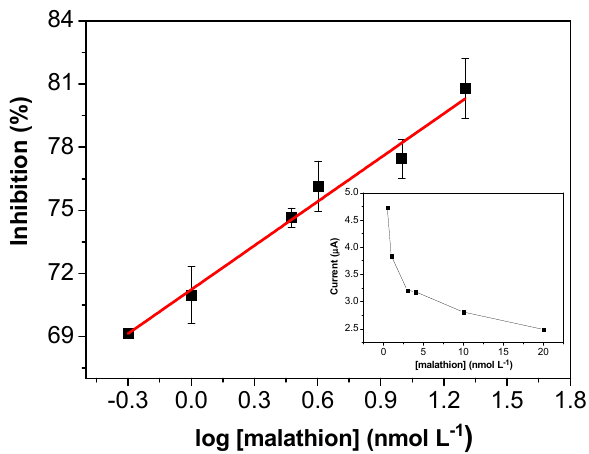
Figure 6. Calibration plot for the malathion biosensor in the range from 0.5 to 20 nmol L − 1 . Insert: plot of current according to malathion concentration.